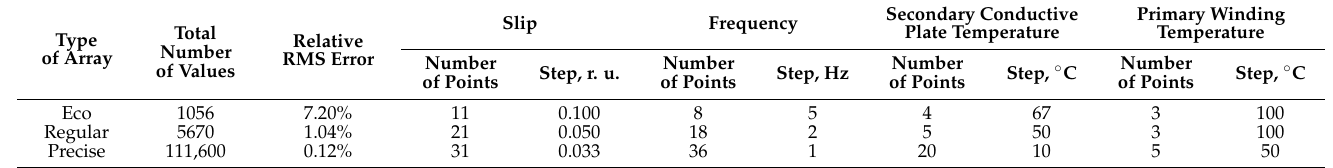
Table 1. An example of multidimension arrays.